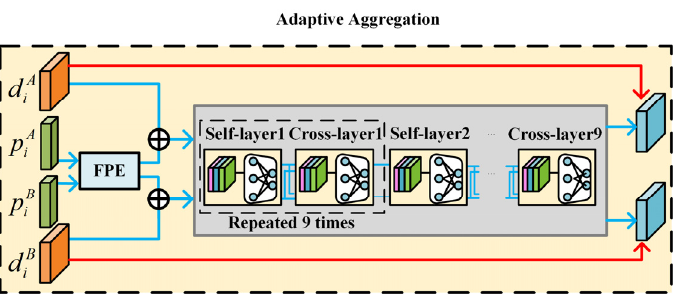
Figure 6. The architecture of adaptive aggregation module. The red lines represent E-mode dataflow and the blue lines represent D-mode dataflow. Self-layering and cross-layering are repeated nine times alternatively.